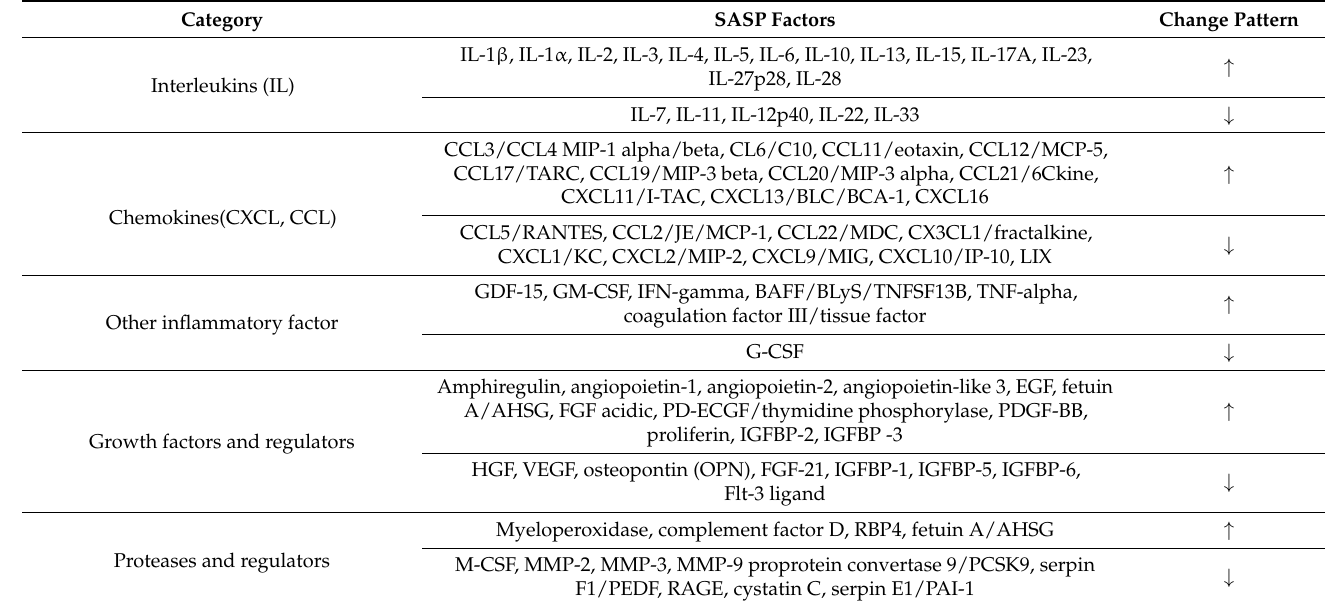
Table 1. Changes in SASP pattern in radiation-induced senescent osteocytes.